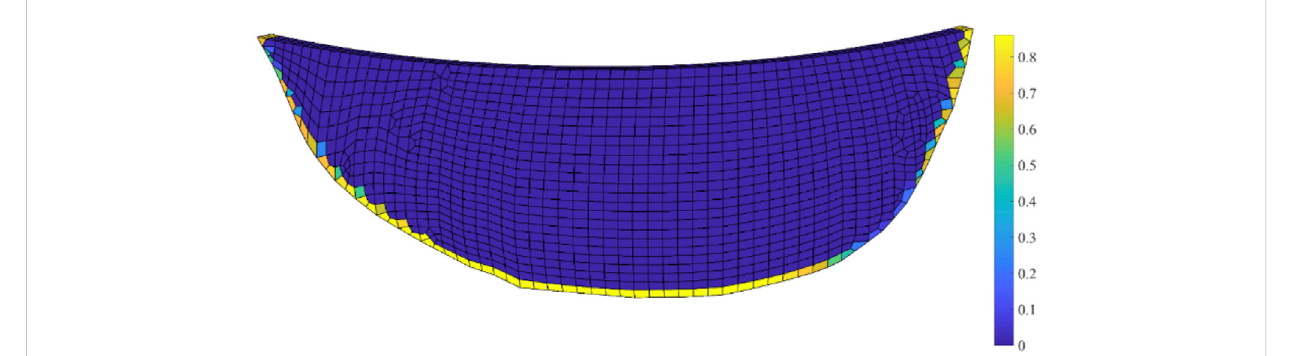
FIGURE 11 Distribution of sensitivity coef fi cient of Gravitational acceleration to tensile damage within dam body.